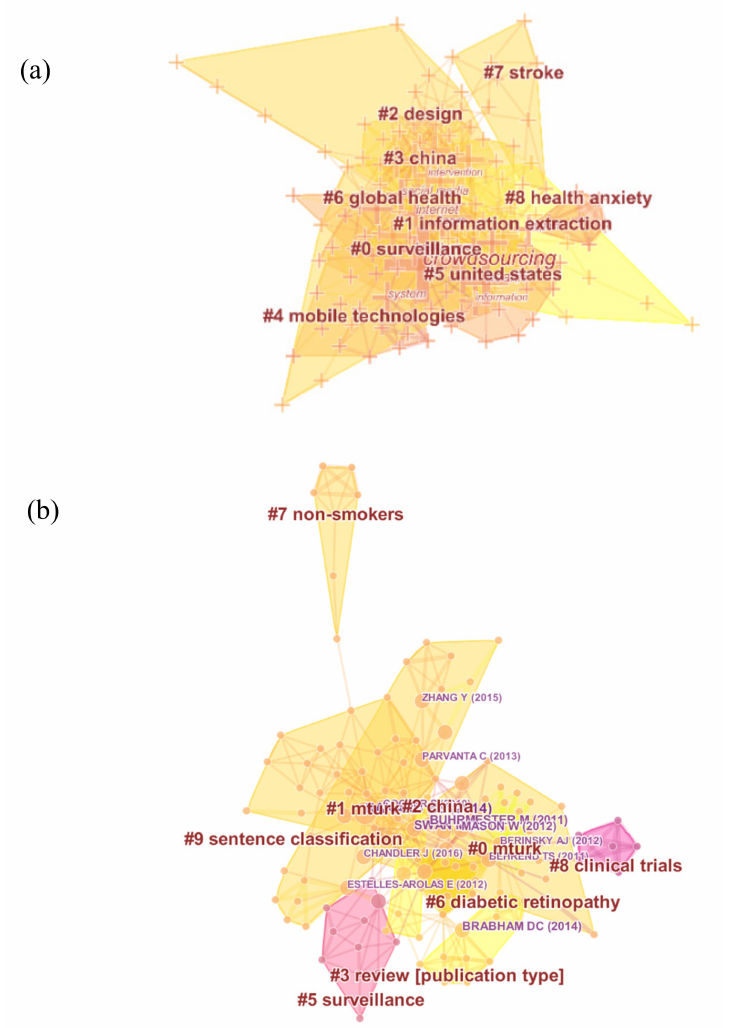
Figure 7. ( a ) Visualization of keywords clusters analysis; ( b ) Visualization of reference co-citation